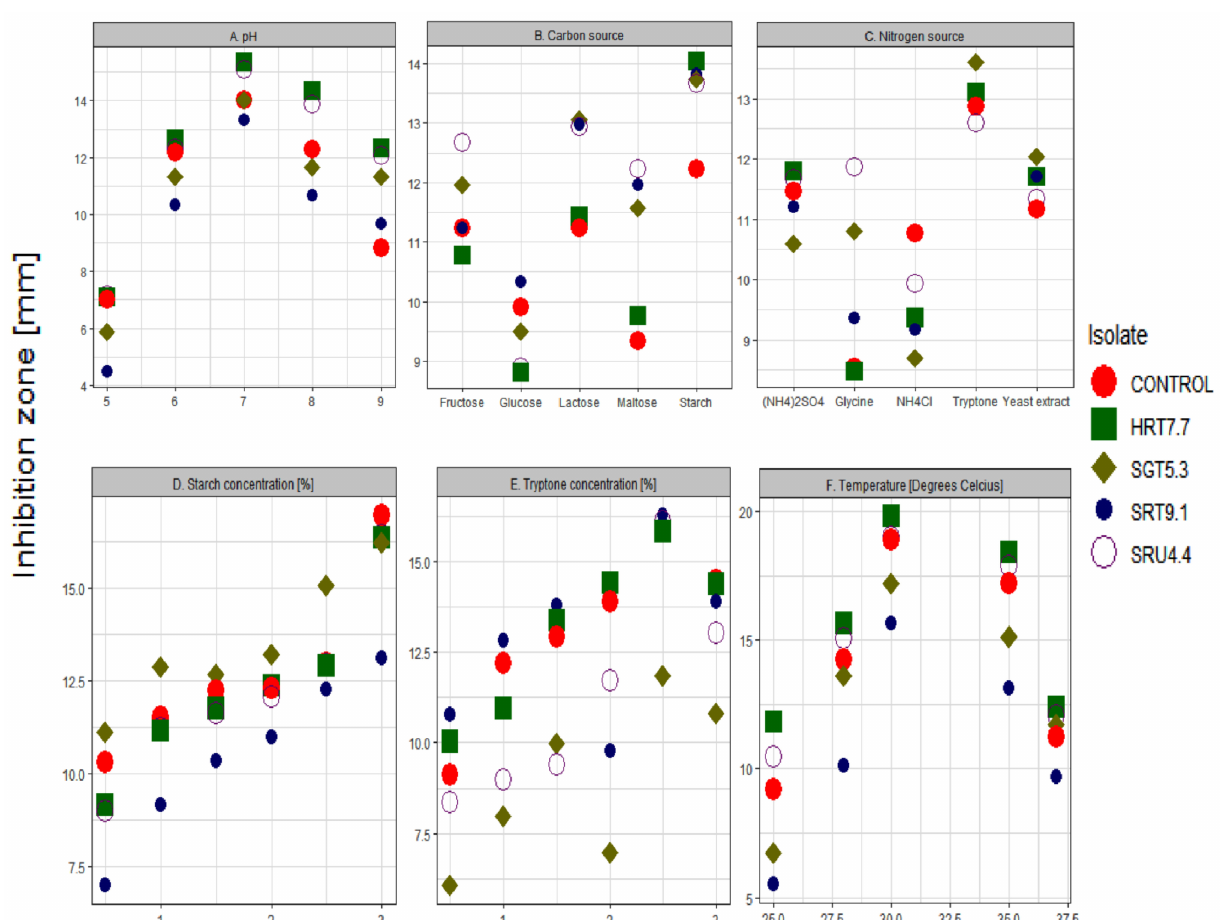
Figure 3. A scatter plot showing inhibition zones of the sweet pepper fruits isolates against the R. solanacearum BD 261 pathogenic strain, at different treatment levels of ( A ) pH, ( B ) carbon sources, ( C ) nitrogen sources, ( D ) starch concentrations, ( E ) tryptone concentrations, and ( F )